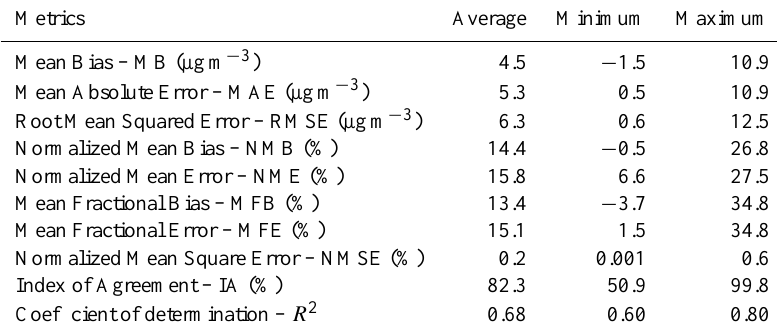
Table 1. Performance statistics for IDW validation.